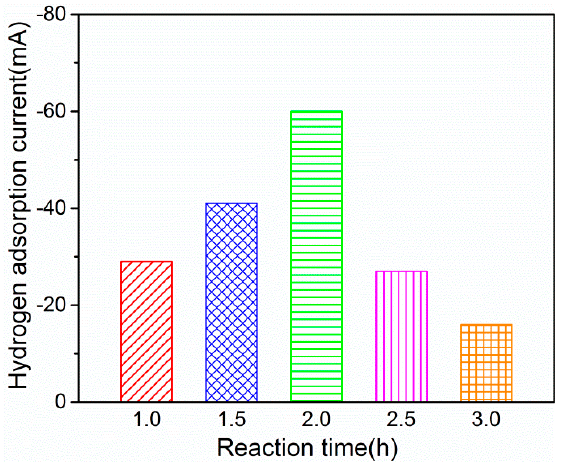
Figure 1. Effect of different reaction times on the Pd-Ag/PPY/Ti electrode. Figure 1. E ff ect of di ff erent reaction times on the Pd-Ag / PPY / Ti